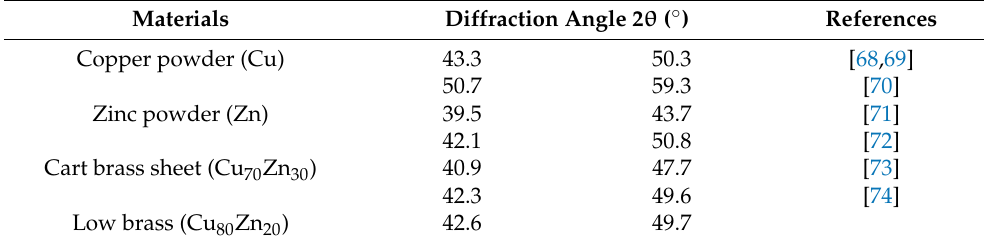
Table 2. Two prominent peaks of X-ray diffraction pattern for copper, zinc, cart brass, and low brass.